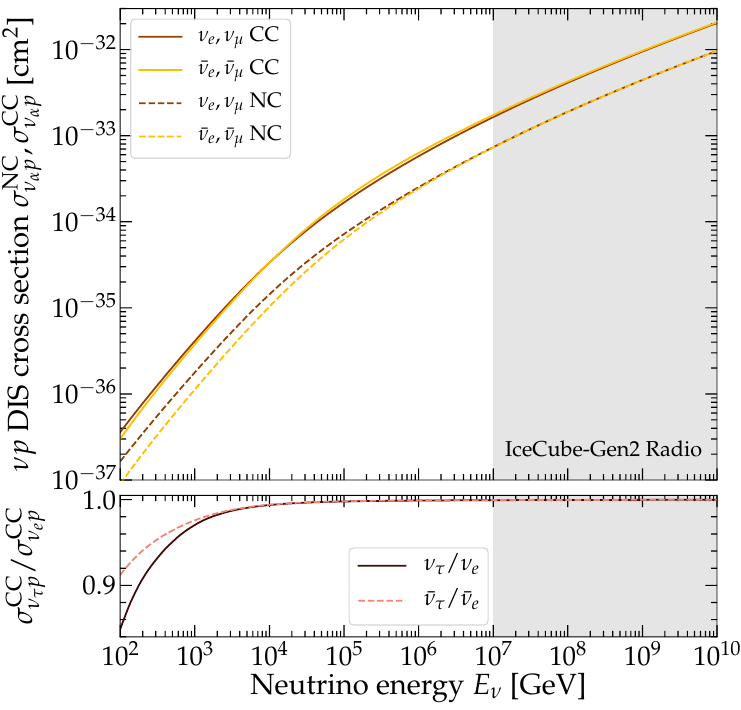
Figure 3 . Neutrino-proton ( νp ) deep inelastic scattering (DIS) total cross section used in our analysis, during the propagation of neutrinos inside the Earth using NuPropEarth [78, 79] and in the computation of event rates at IceCube-Gen2. See section 3.1 for details. This is the central value of the BGR18 calculation [63], extracted from the HEDIS [78] module of GENIE [92]. The shaded region is the approximate energy window where the radio array of IceCube-Gen2 will be sensitive. Top: cross sections for ν and ν ; they are equal. Bottom: ratio of the ν to ν CC cross e µ τ e sections showing the low-energy suppression of the